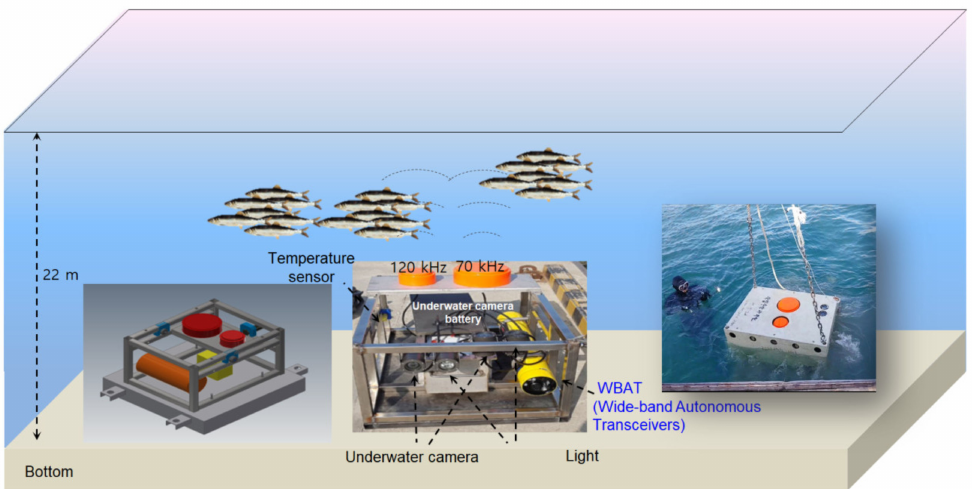
Figure 2. Design of the acoustic monitoring system in Jinhae Bay,